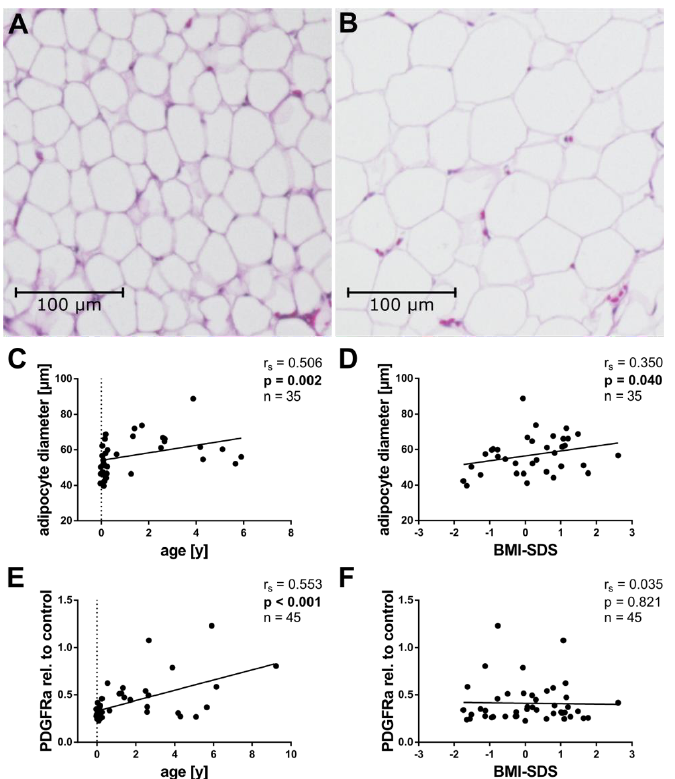
Figure 1. Association of adipocyte size and PDGFRa expression with age and BMI-SDS. ( A , B ) Pictures of representative adipose tissue sections stained with haematoxylin and eosin from a patient with small ( A ) and a patient with large ( B ) adipocytes. ( C , D ) Adipocyte diameter was plotted against age ( C ) and BMI-SDS ( D ). Adipocyte size correlated positively with age and BMI-SDS in our collective ( C , D ). ( E , F ) Total RNA was isolated, reverse transcribed, and subjected to qPCR analysis using specific primer pairs as indicated. PDGFRa gene expression was calculated as described in Methods and plotted against age. PDGFRa expression correlated positively with age ( E ) but not with BMI-SDS ( F ) in the collective. Spearman correlation coefficient r s and p value, as well as number of subjects, are given in each scatter plot. Significant p values ( p < 0.05) are indicated in bold. Trend lines were calculated as linear